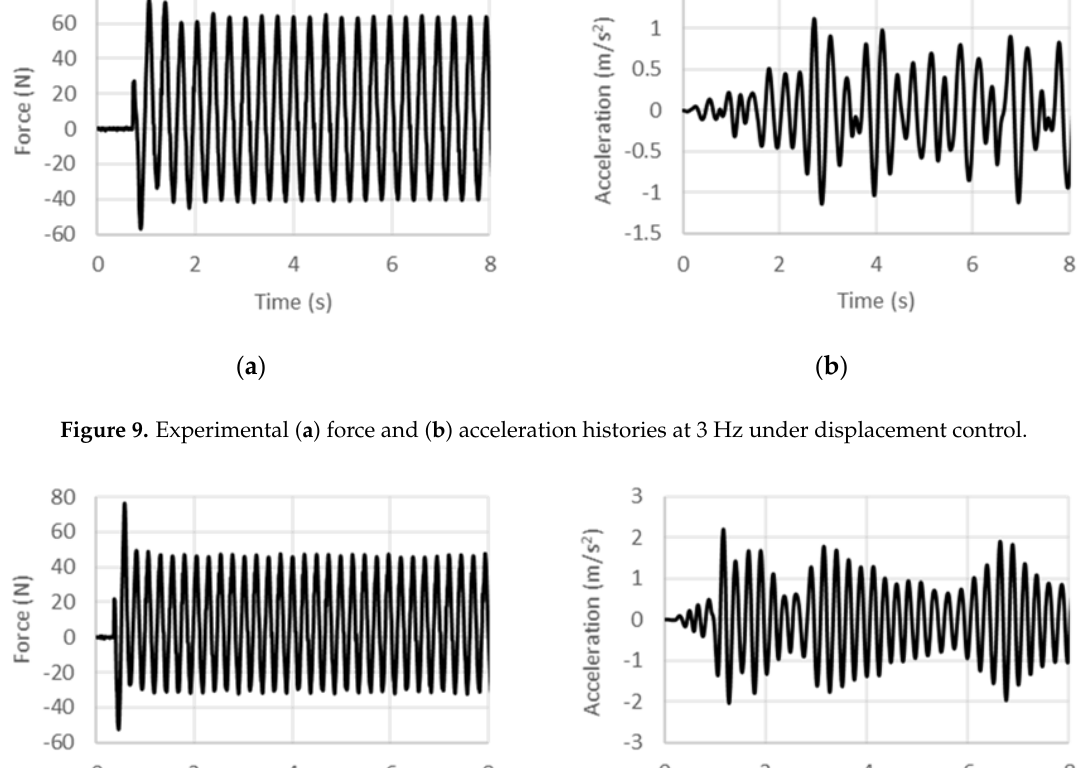
Figure 8. Experimental ( a ) force and ( b ) acceleration histories at 2 Hz under displacement control.